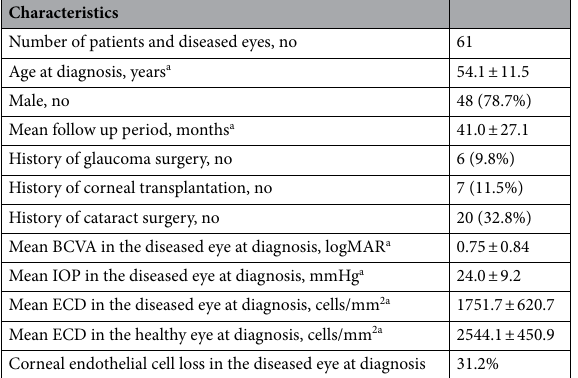
Table 1. Demographic data and initial clinical manifestation of patients with CMV anterior segment infection. No. number, BCVA best corrected visual acuity, IOP intraocular pressure, ECD endothelial cell density. a Demonstrated as mean ± standard